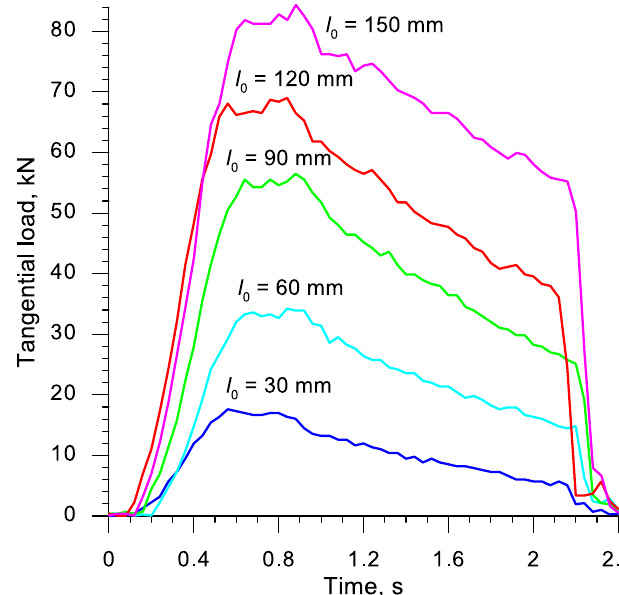
Figure 4. Distributions of the tangential force (moving the moveable tool) recorded during the rotational compression tests performer in laboratory conditions at the Lublin University of Technology.